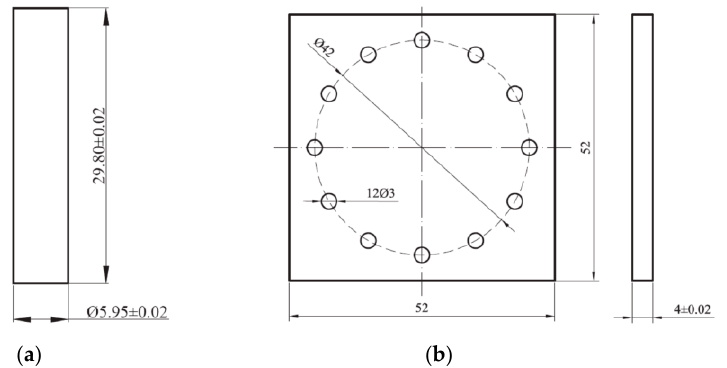
Figure 2. Projectile and target processing drawing (unit: mm). ( a ) Projectile. ( b ) Target.